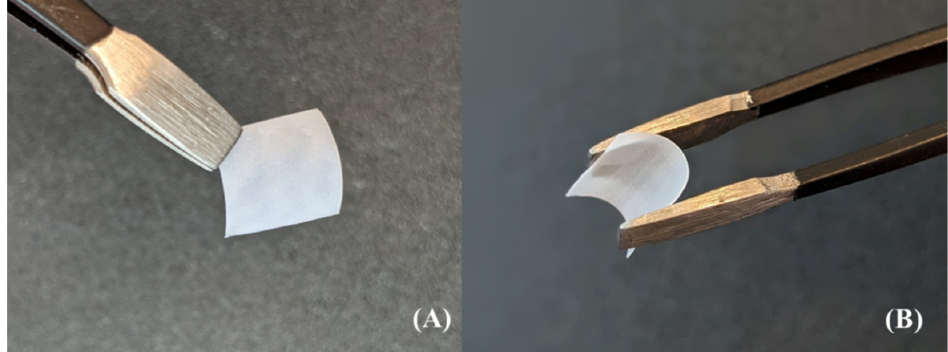
Figure 1. ( A ). 1 × 1 cm 2 sample of ZnO/PVA/IL membrane. ( B ) Demonstration of its high flexibil ‐